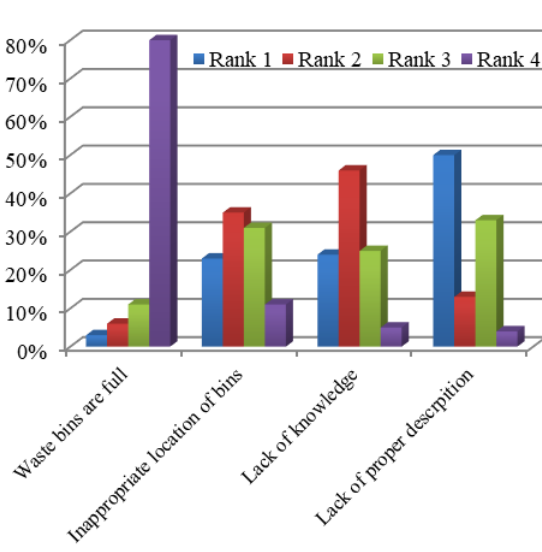
Figure 6. Responses to the importance of